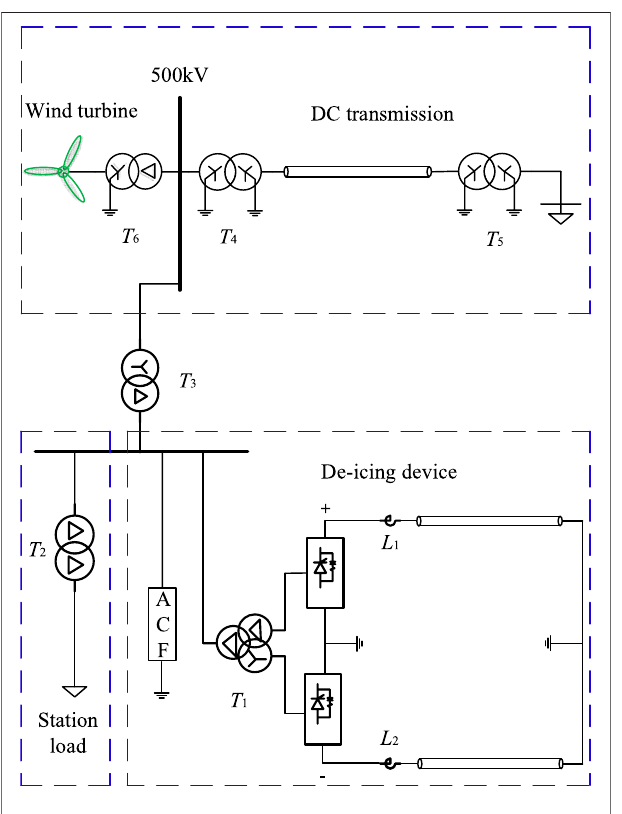
FIGURE 1 | DC de-icing